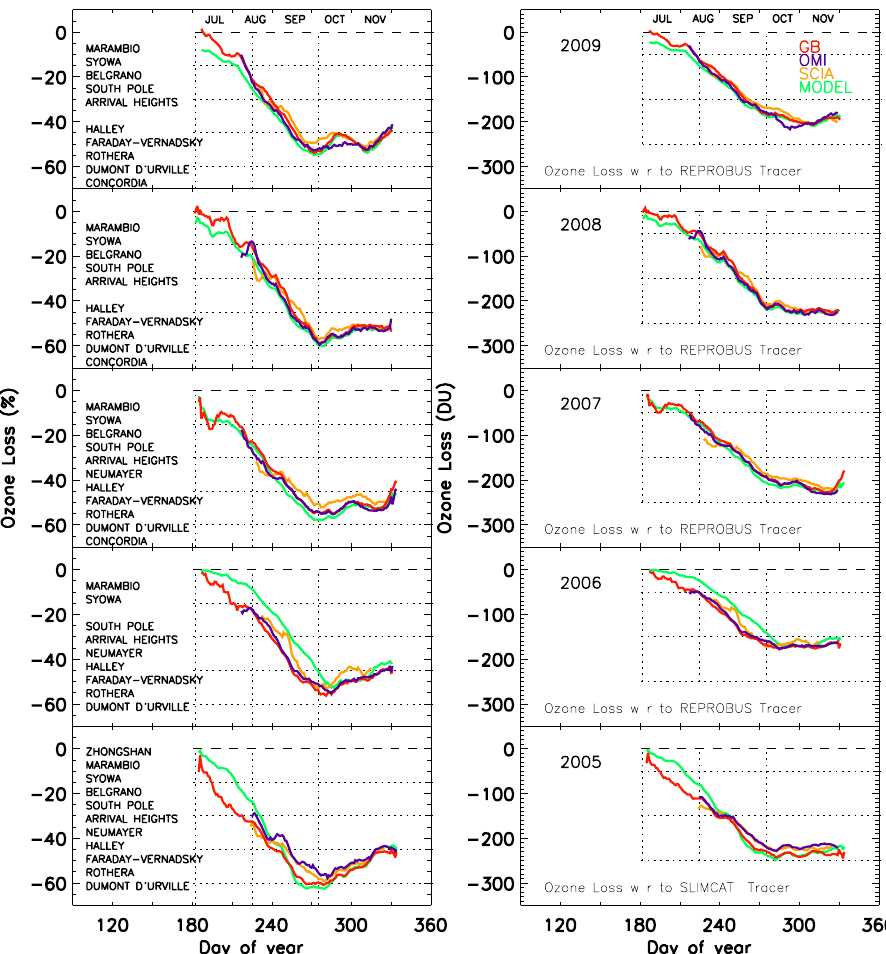
Fig. 6. Vortex averaged (ten-day boxcar average) ozone loss estimated from the ground-based (GB) measurements (as listed in the plots) in red, the OMI observations in blue (OMI), the SCIAMACHY measurements in dark yellow (SCIA) and the model simulations by REPROBUS in 2006–2009 and SLIMCAT in 2005 in green (MODEL) for the Antarctic winters 2005–2009 (Left: percent, right: DU). The loss in absolute unit (DU) is estimated as ozone avg -tracer avg and its relative loss (%) is computed as 100 × (ozone avg -tracer avg )/tracer avg . The ozone avg /tracer avg represents the average of the measurements/simulations inside the vortex from all stations. The SCIA average excludes South Pole measurements due to unavailability. The dotted vertical lines represent day 182 (1 July), and day 225 and 275, the time window used for the computations of daily ozone loss rates. The horizontal lines represent 15, 30, 45 and 60%, and 50, 150 and